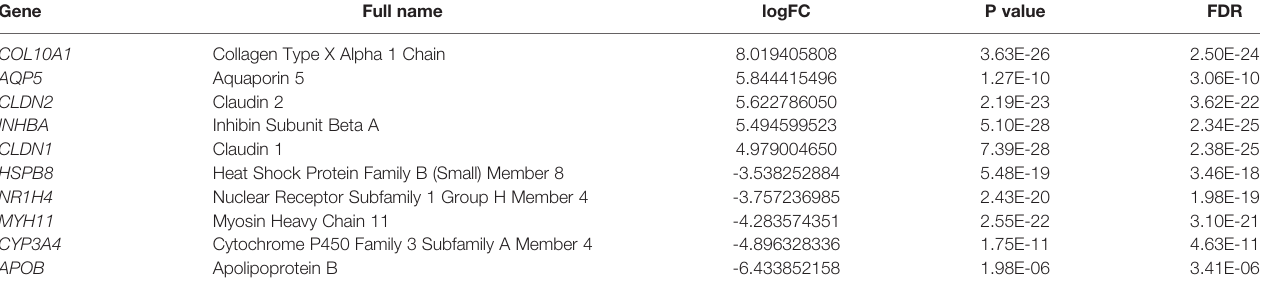
TABLE 1 | Top fi ve autophagy-associated genes signi fi cantly upregulated and downregulated in